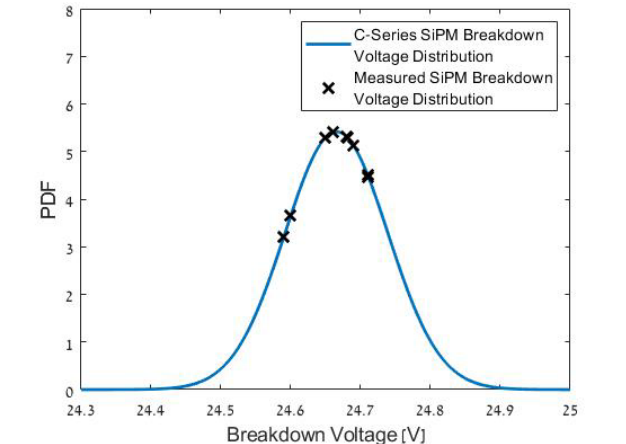
Fig. 3. Ten breakdown voltages that were calculated marked on the normal probability density function plotted using the standard deviation from Table Ι